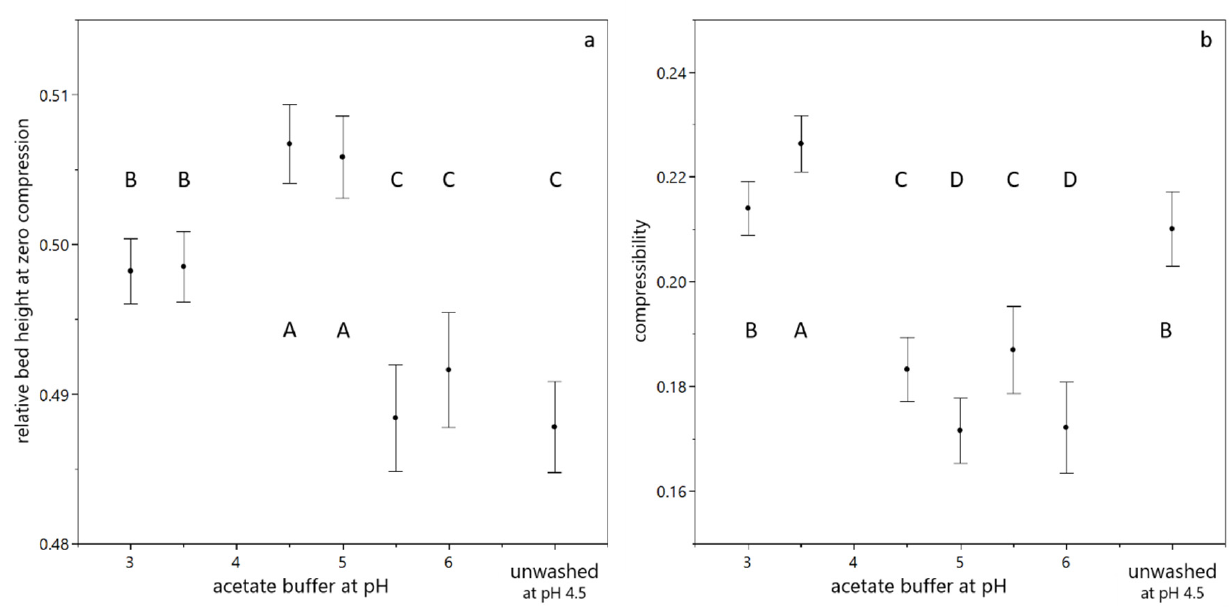
Figure 3. Compression behavior of yeast suspensions, calculated according to Equation (3). The relative bed height at zero compression ( a ) and the compressibility upon centrifugal acceleration ( b ) as a function of the buffer and its pH value. The error bars indicate the standard deviation from fitting the model equation. The connecting letters are obtained from a student’s t -test with a 95% confidence interval.